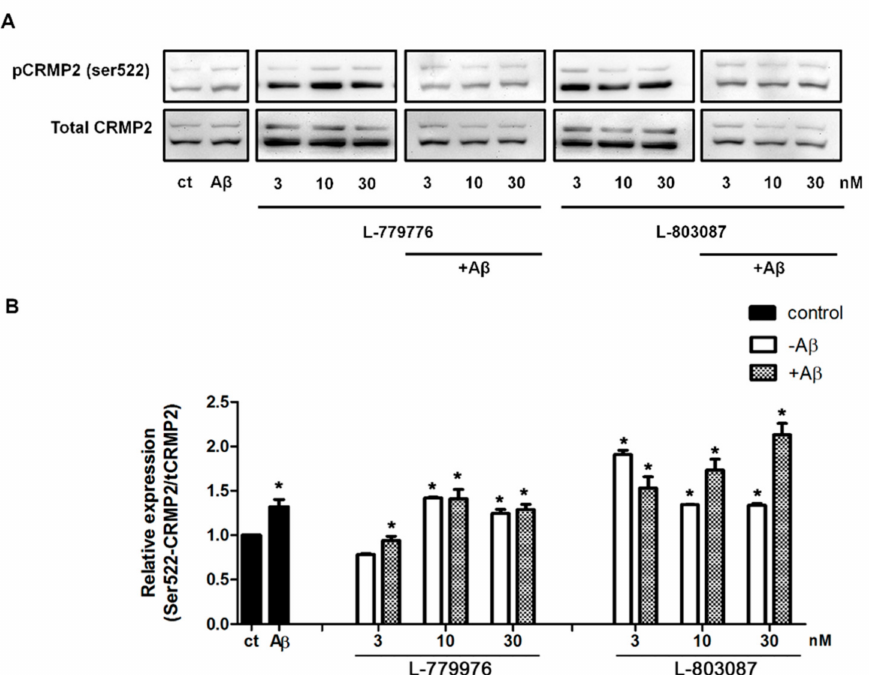
Figure 6. SSTR specific agonist effect on Ser522-CRMP2 phosphorylation. ( A ). Representative Western blot showing changes in the level of S522-CRMP2 phosphorylation in cells, following treatment with increasing concentrations of SSTR2 and SSTR4-specific agonist (3, 10, 30 nM) in the presence or absence of A β 1-42 (5 µ M). ( B ). The densitometry analysis of Western blot shows a significant inhibition of Ser522 phosphorylation upon treatment with L-779976 (3 nM) in the absence or presence of A β 1-42 . L-779976 (10 and 30 nM) alone, which resulted in the moderate elevation of phosphorylation at the Ser522 site compared to the untreated control. In the presence of A β 1-42 , L-779976 (10 and 30 nM) displayed moderate changes when compared to the cells treated with A β 1-42 . In the presence of A β 1-42 , L-803087 induced a dose-dependent increase of Ser522 phosphorylation, resulting in the highest level of expression at 30 nM treatment of L-803087. The data represent the mean ± SD of three independent experiments. * p < 0.05 against respective